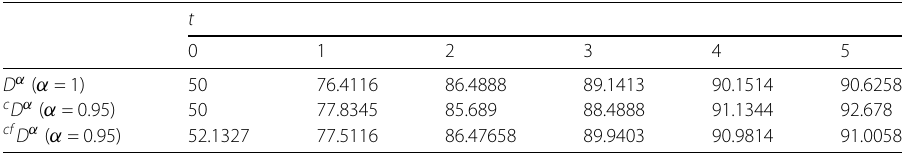
Table 1 Comparison between the standard derivative, Caputo fractional derivatives, and Caputo–Fabrizio fractional derivative for S ( t ) t